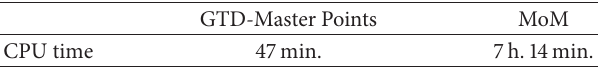
Table 1: Comparison of the CPU time need for the analysis when GTD-Master Points and MoM techniques are applied.